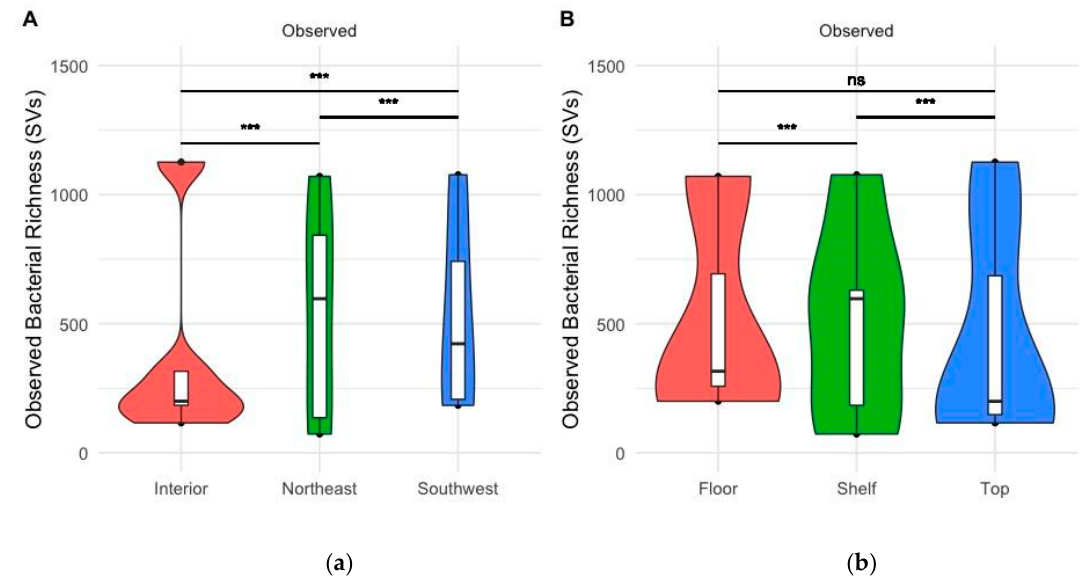
Figure 6. Bacterial species’ richness in indoor settled-dust from different ( a ) locations within the building; ( b ) heights relative to the floor.